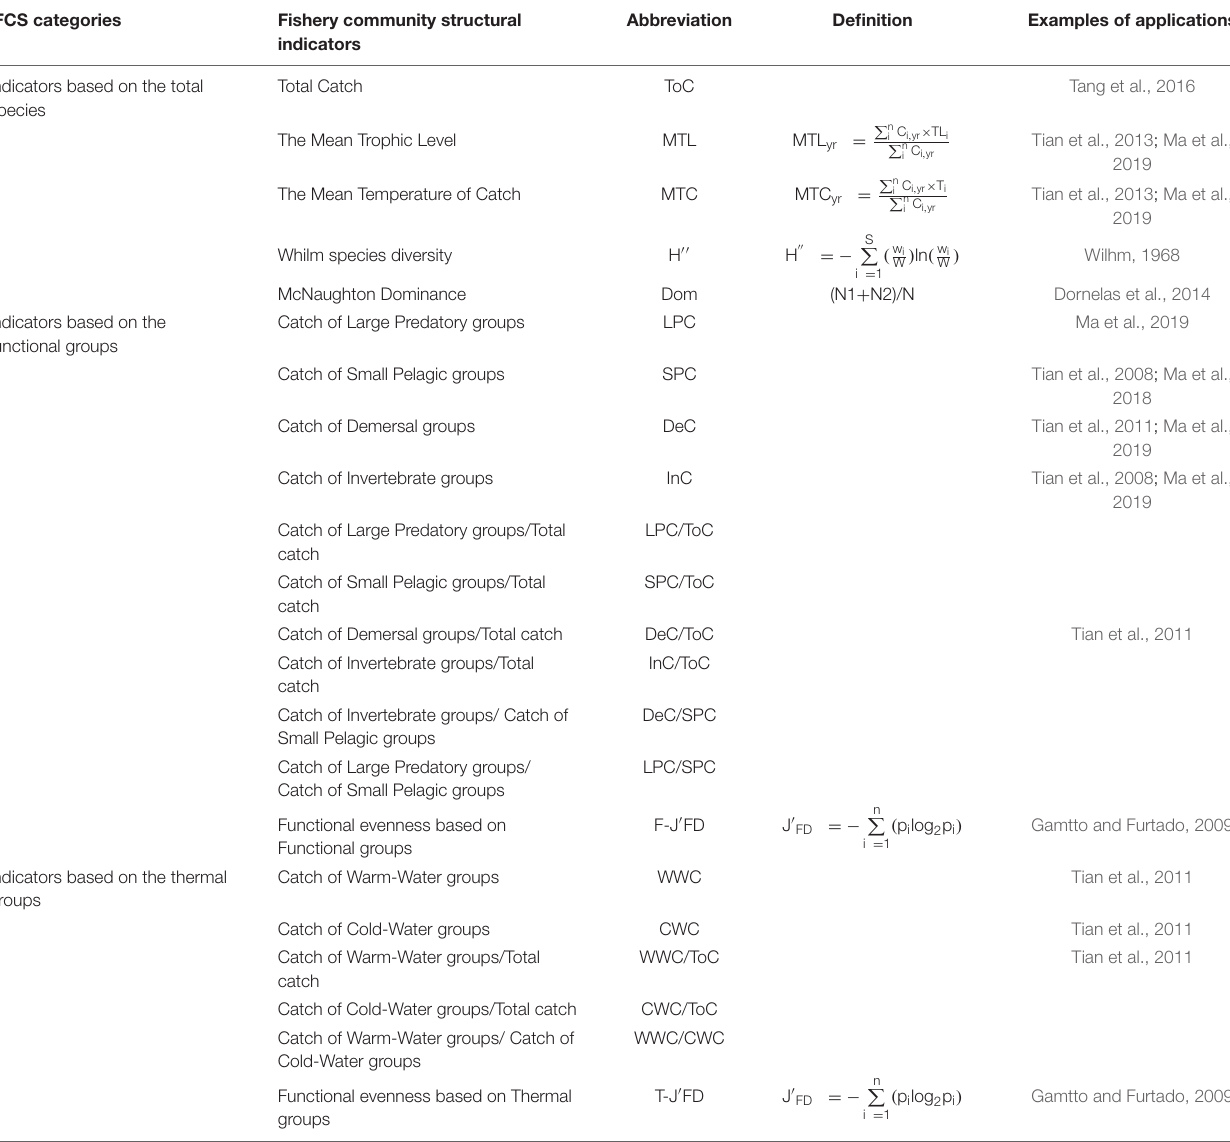
TABLE 1 | List of fishery community structural indicators tested for